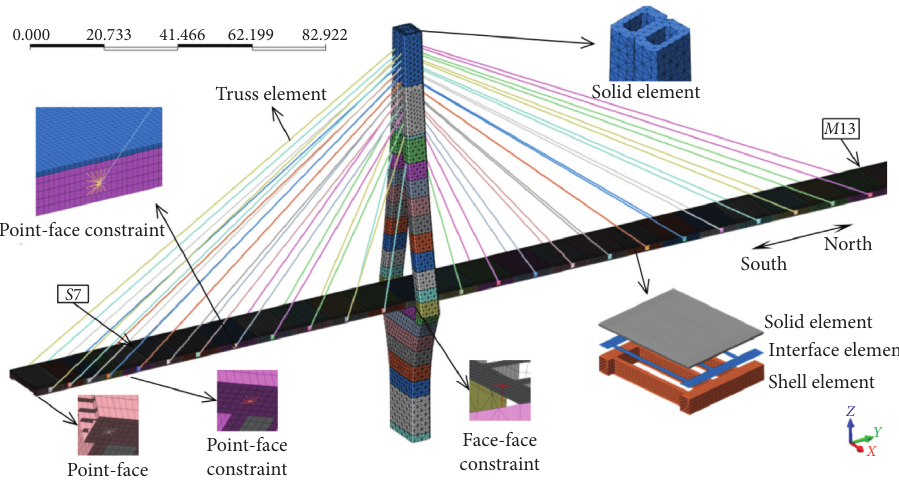
Figure 7: The finite element model with a mixed element schematic diagram.